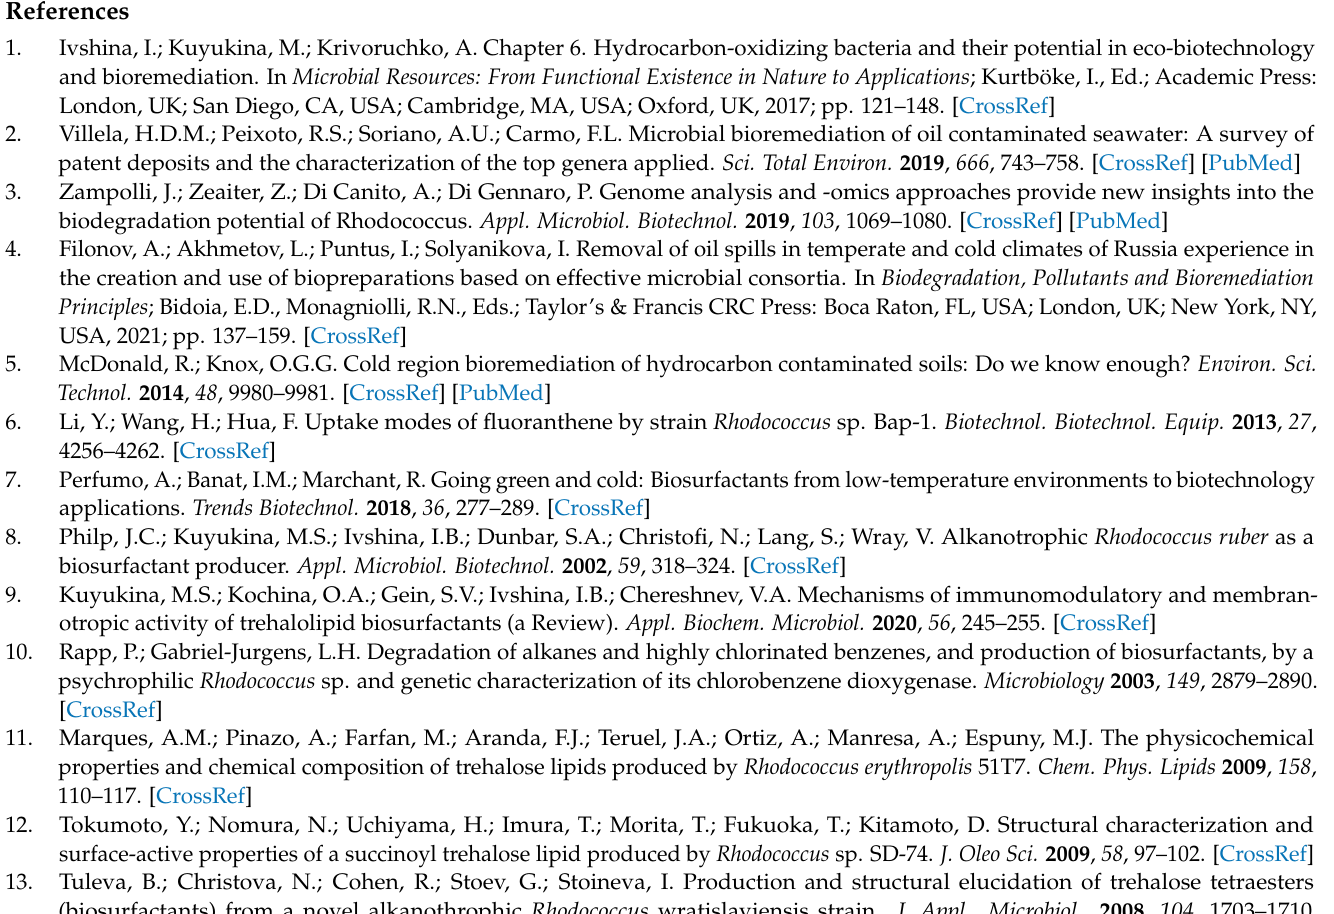
medium, Figure S2: Total cell lipids content in X5 (a) and S67 (b) strains during batch cultivation with hexadecane, Figure S3: Chromatograms of fatty acid methyl esters present in extracellular biosurfactants produced by strain X5 when grown on hexadecane in different aggregate states, Figure S4: Chromatograms of methyl esters of fatty acids present in extracellular biosurfactants produced by strain S67 when grown on hexadecane in different aggregate